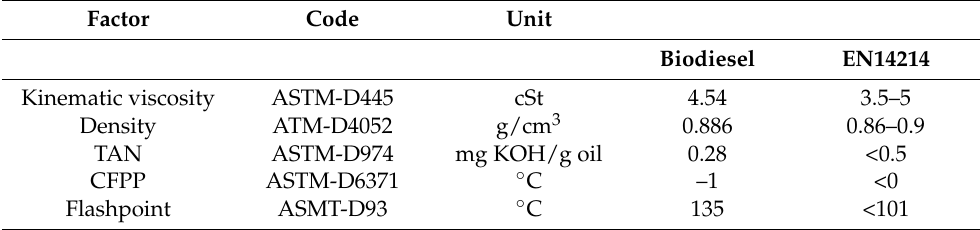
Table 7. Comparison between produced biodiesel properties and European biodiesel standard EN14214. Factor Code Unit Kinematic vis- ASTM-D445 cosity Density ATM-D4052